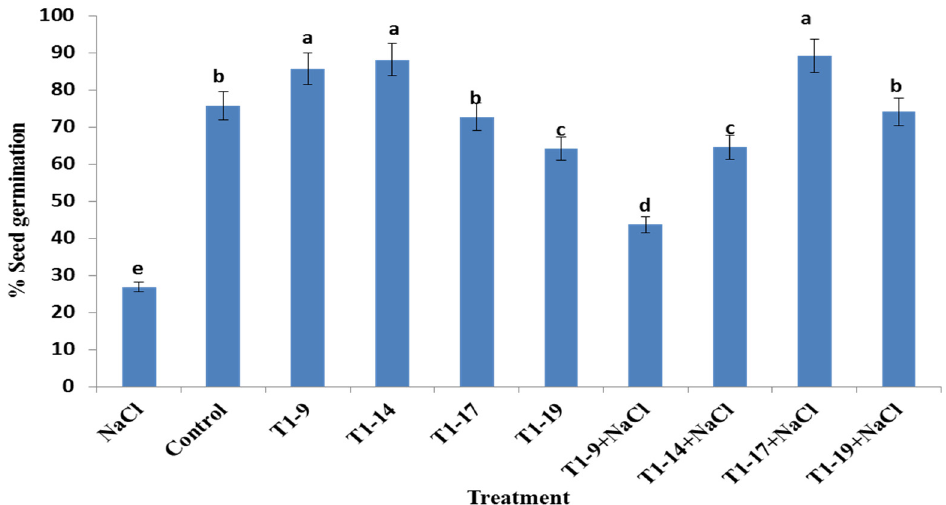
Figure 2. Effect of seed biopriming with PGPBs on the germination of durum wheat under control and salt stress conditions. The seeds were incubated in a suspension of 1 × 10 8 cfu/mL bacteria on 0 and 125 mM NaCl at room temperature for 30 min. Bars represent the standard error of the mean (SEM). Different letters above the error bars indicate a significant difference at p ˂ 0.05. Control, no NaCl and no PGPB; NaCl, no PGPB in salinized soil (125 mM NaCl); T1, bioprimed seed; 9, Bacillus pumilus MA9; 14, Virgibacillus halodenitrificans MA14; 17, Bacillus subtilis MA17; 19, Bacillus safensis MA19.